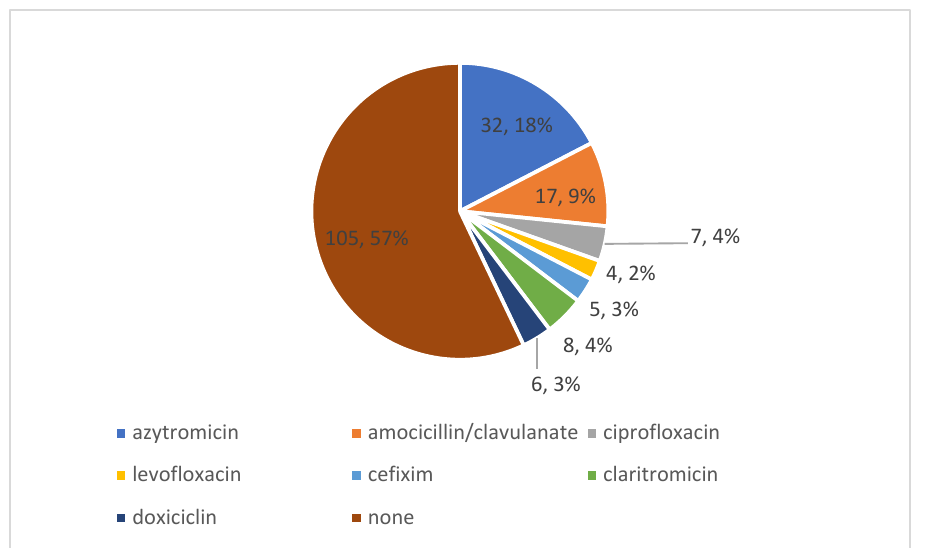
Figure 1. Antibiotics used before hospitalization.